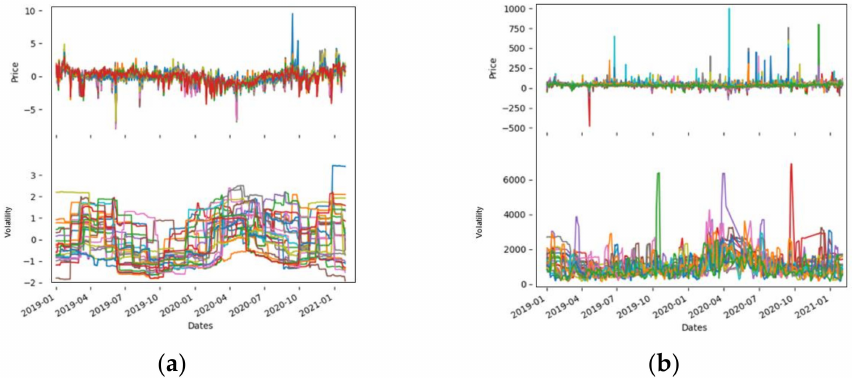
Figure 6. These figures show an example of the German day-ahead prices ( a ) and intraday prices ( b ). The visualization applies standardized data (see Formula (3)). Figure 6 got generated using the same code in